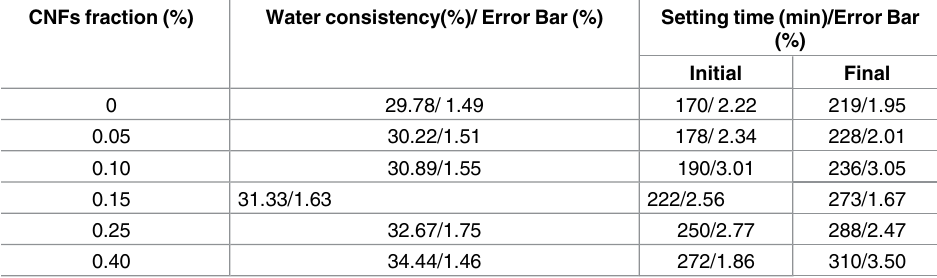
Table 1. Water consistency and initial and final setting times for cement